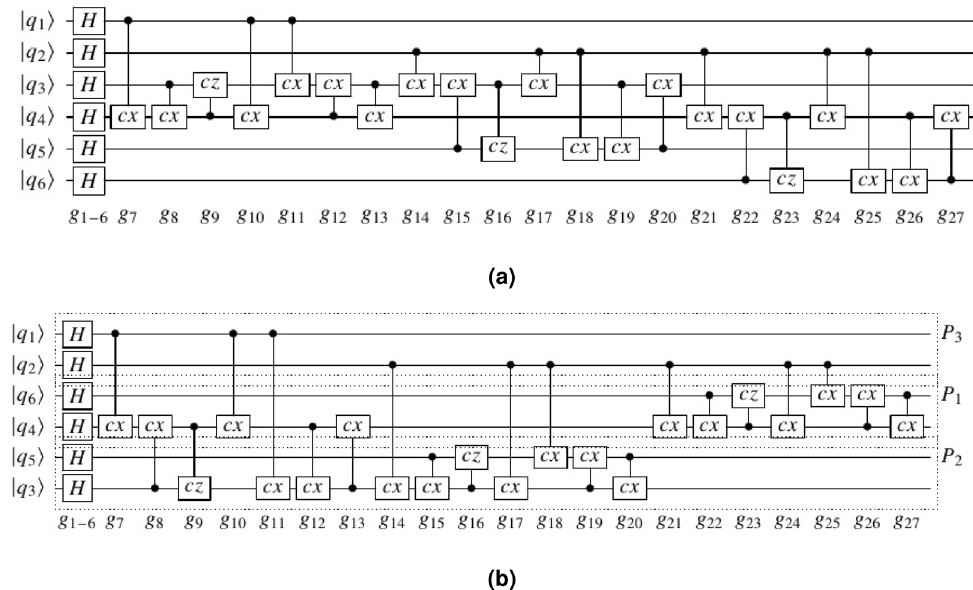
Figure 4. ( a ) Circuit 2–4 dec. ( b ) The obtained circuit from applying Level I. The gate g